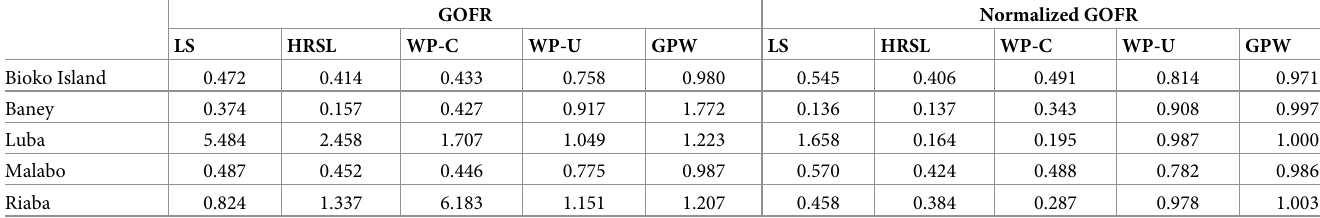
Table 3. This compares the goodness-of-fit ratio across the three maps, aggregating HRSL and both WP surfaces to 1 km resolution to match LS and GPW. Normali- zation discounts the effect of uniform changes in population size, which provides a better comparison between high-and-low population districts.